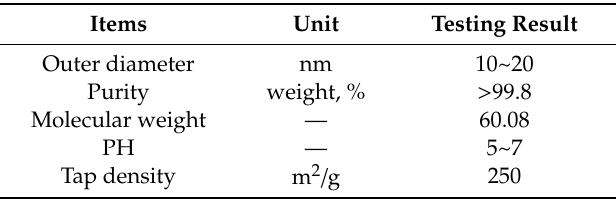
Table 1. Physical properties of nano-SiO 2.